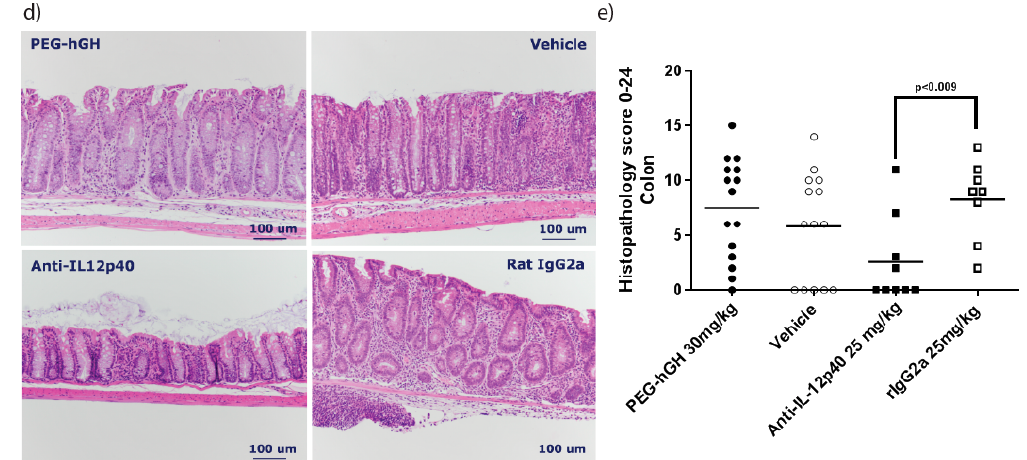
Figure 5. Therapeutic evaluation of the effects of pegylated-hGH (PEG-hGH) in the PAC model with established colitis. Arrows indicate dosing with PEG-hGH. ( a ) Weight change (% relative to pre-dosing with piroxicam) during the study with indications of dosing with PEG-hGH. The four treatment groups are indicated; ( b ) Plasma IGF-1 profile from the PEG-hGH treated group. Following PEG-hGH injection a sustained IGF-1 response is observed the following days; ( c ) Colonic weight:length ratio of the treated groups measured at day 10; ( d ) Representative colonic HE stains of the 4 treatment groups; ( e ) Histopathological scoring of colonic disease severity evaluated at day 10. Mean values are presented with SEM in ( a ). rIgG: rat IgG antibody.